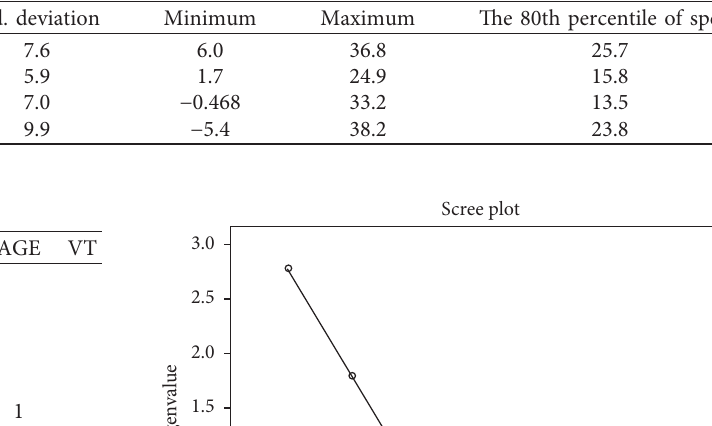
Table 4: Descriptive statistical of operation parameters.